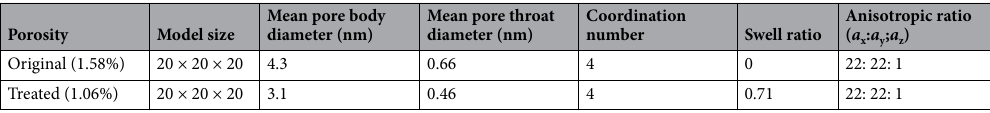
Table 4. Original Longmaxi shale PNW parameters 70,71,73